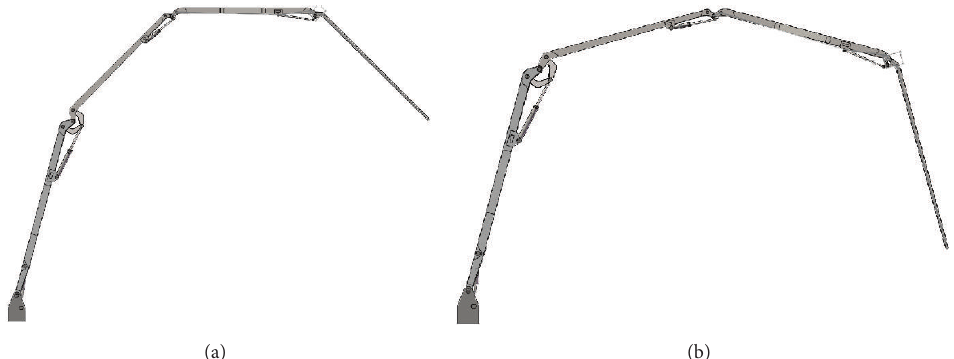
Figure 6: Manipulator postures of ground condition (a) and wall condition (b).